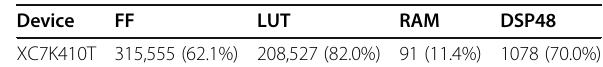
Table 2 Hardware resource consumption of EV station